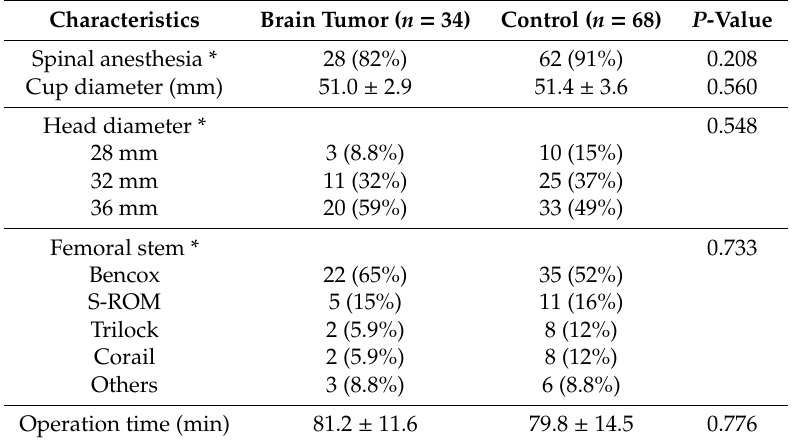
Table 4. Surgical characteristics of